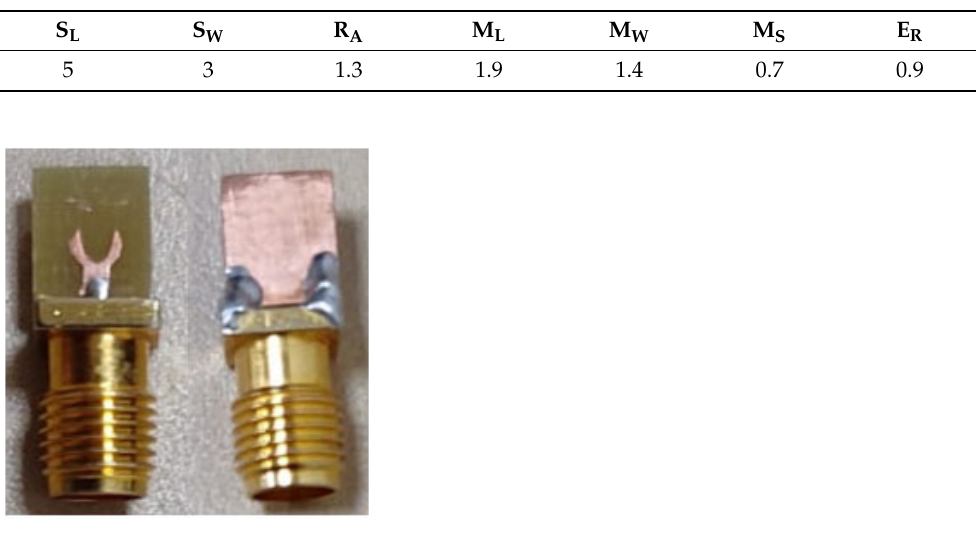
Figure 1. The projected antenna design ( a ) radiating plane ( b ) ground plane. Table 1. Geometrical dimensions of the proposed antenna (mm).